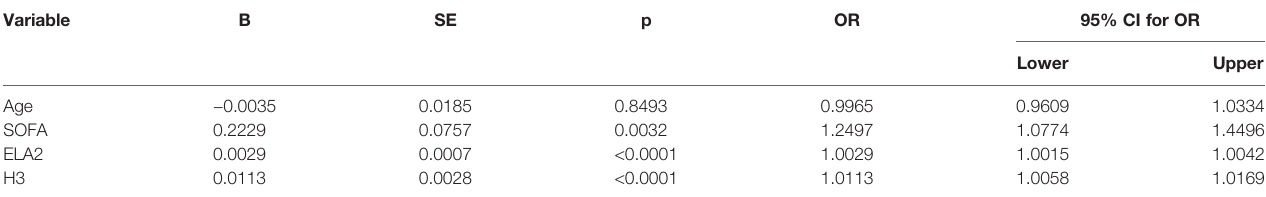
TABLE 5 | Univariate logistic regression analysis for possible risk factors for prognosis.